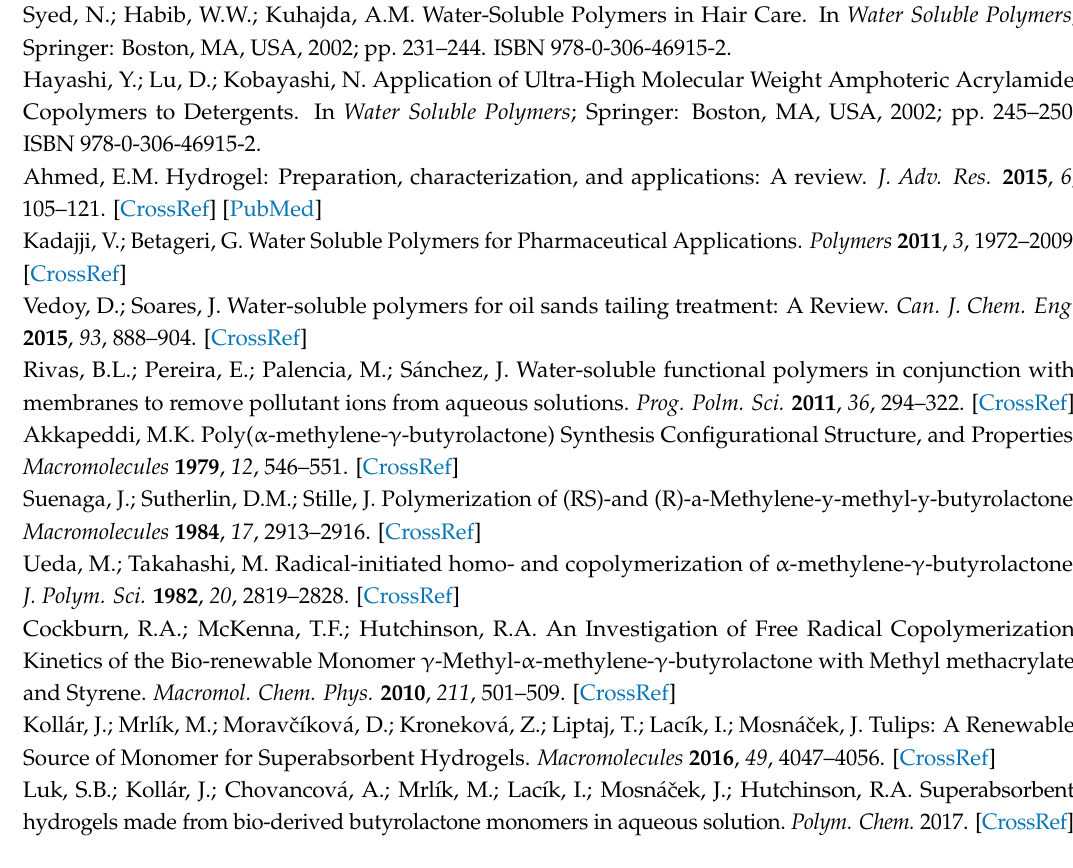
Supplementary Materials: The table and additional figures discussed in the text are available online at